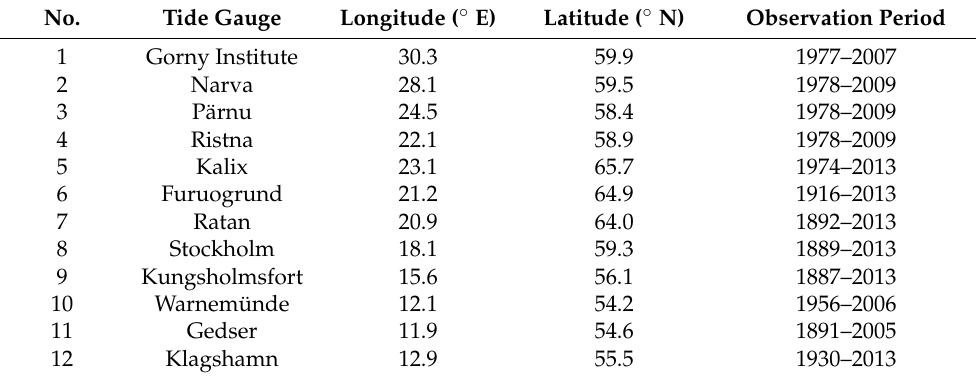
Table 1. The tide gauges which data were used in the study. Numbers in column 1 correspond to stations in Figure